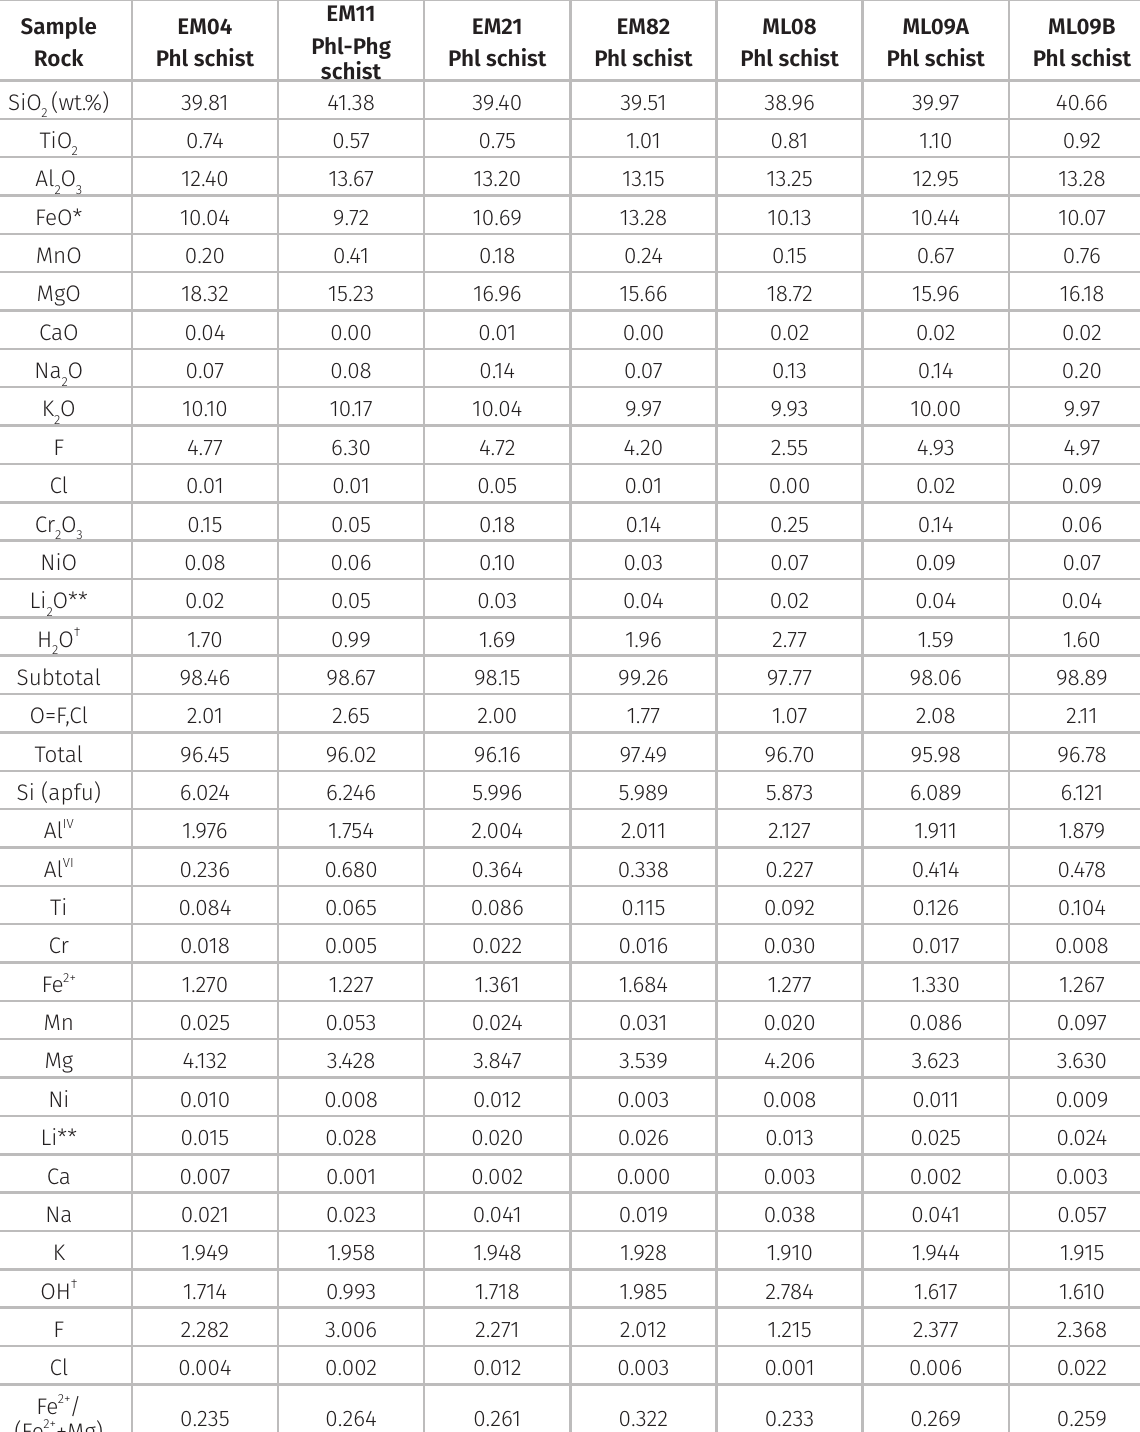
Table II. EPMA average chemical composition for trioctahedral micas of Paraná emerald deposit.